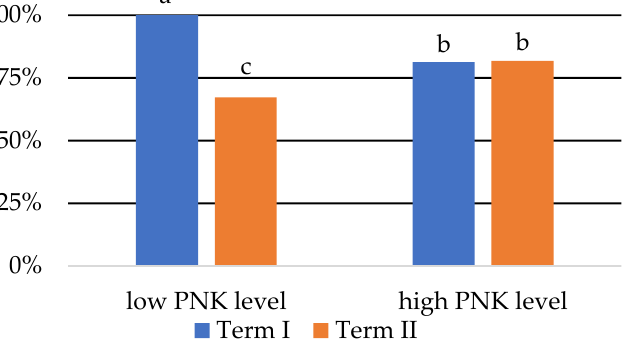
Figure 4. The cadmium uptake efficiency index by Hydrocharis morsus-ranae in the three tested growing seasons. Similar letter indicates no significant difference ( p ≤ 0.05). Table 5. The fresh weigh of Hydrocharis morsus-ranae (g) in the three tested growing seasons. Conditions